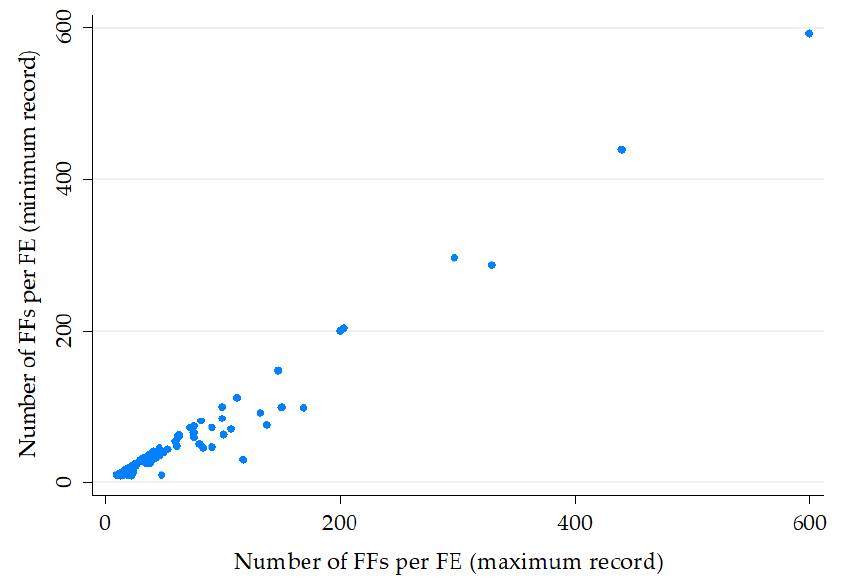
Figure 2. Relationship between the minimum and maximum number of FFs, as reported by the various sources for each FE. Each dot in the diagram corresponds to a flash flood event indicating the respective combination of minimum and maximum number of FFs recorded for this event.